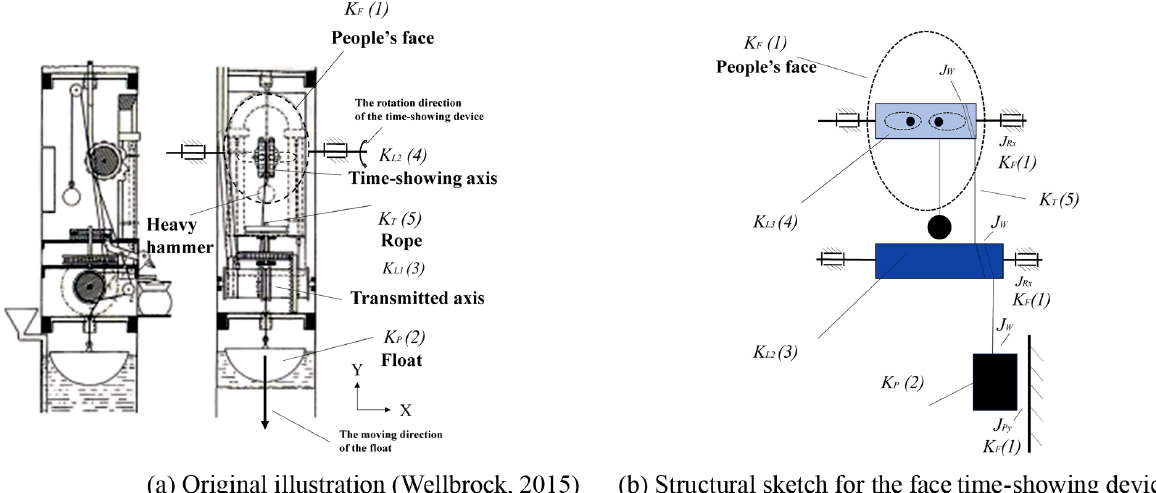
Figure 13. Reconstruction of Pseudo-Archimedes’s water